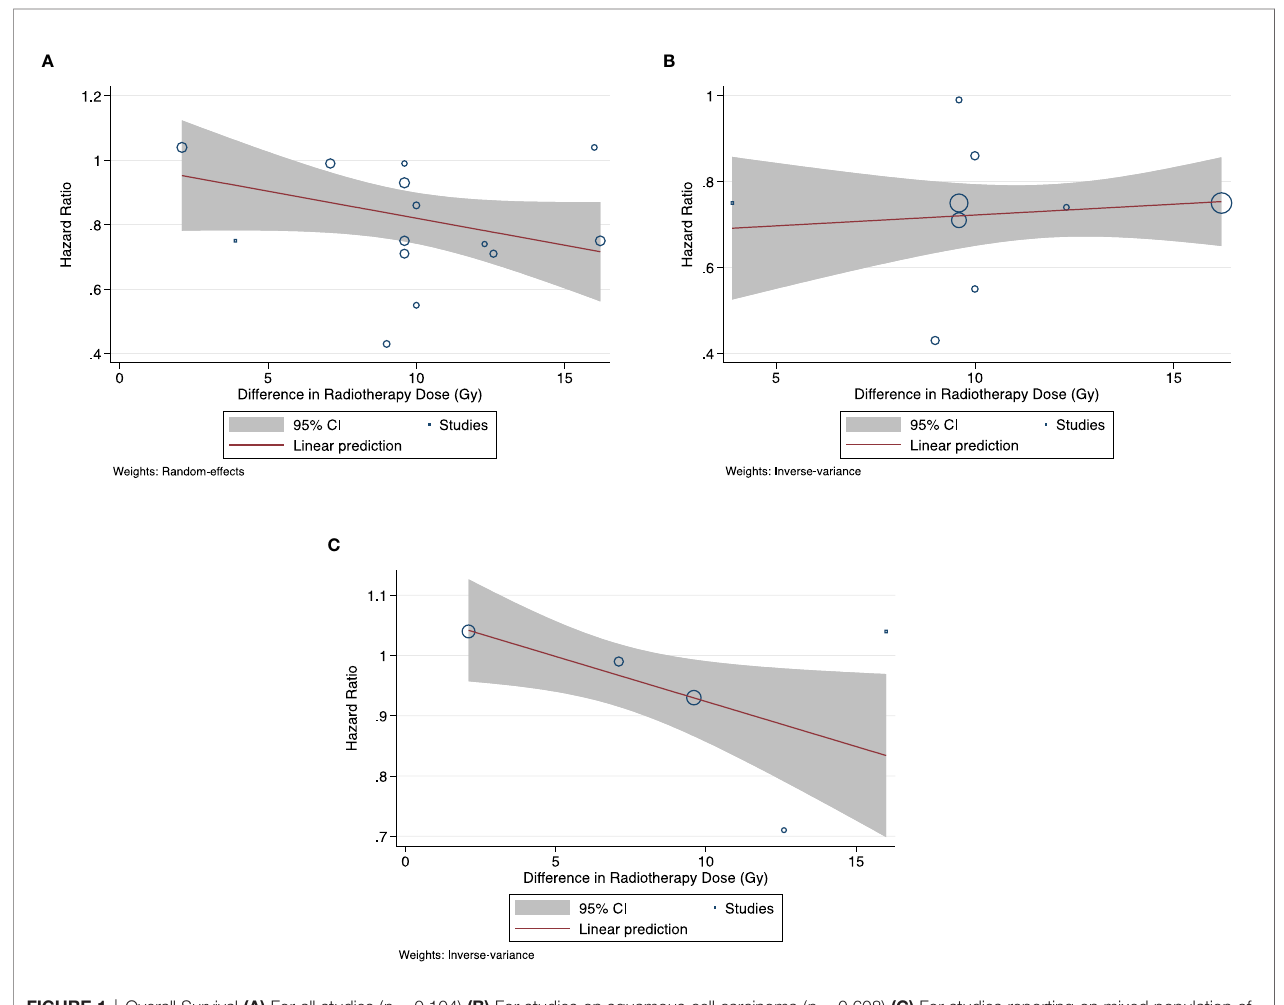
FIGURE 1 | Overall Survival (A) For all studies ( p = 0.104) (B) For studies on squamous cell carcinoma ( p = 0.608) (C) For studies reporting on mixed population of squamous cell carcinoma and adenocarcinoma ( p =